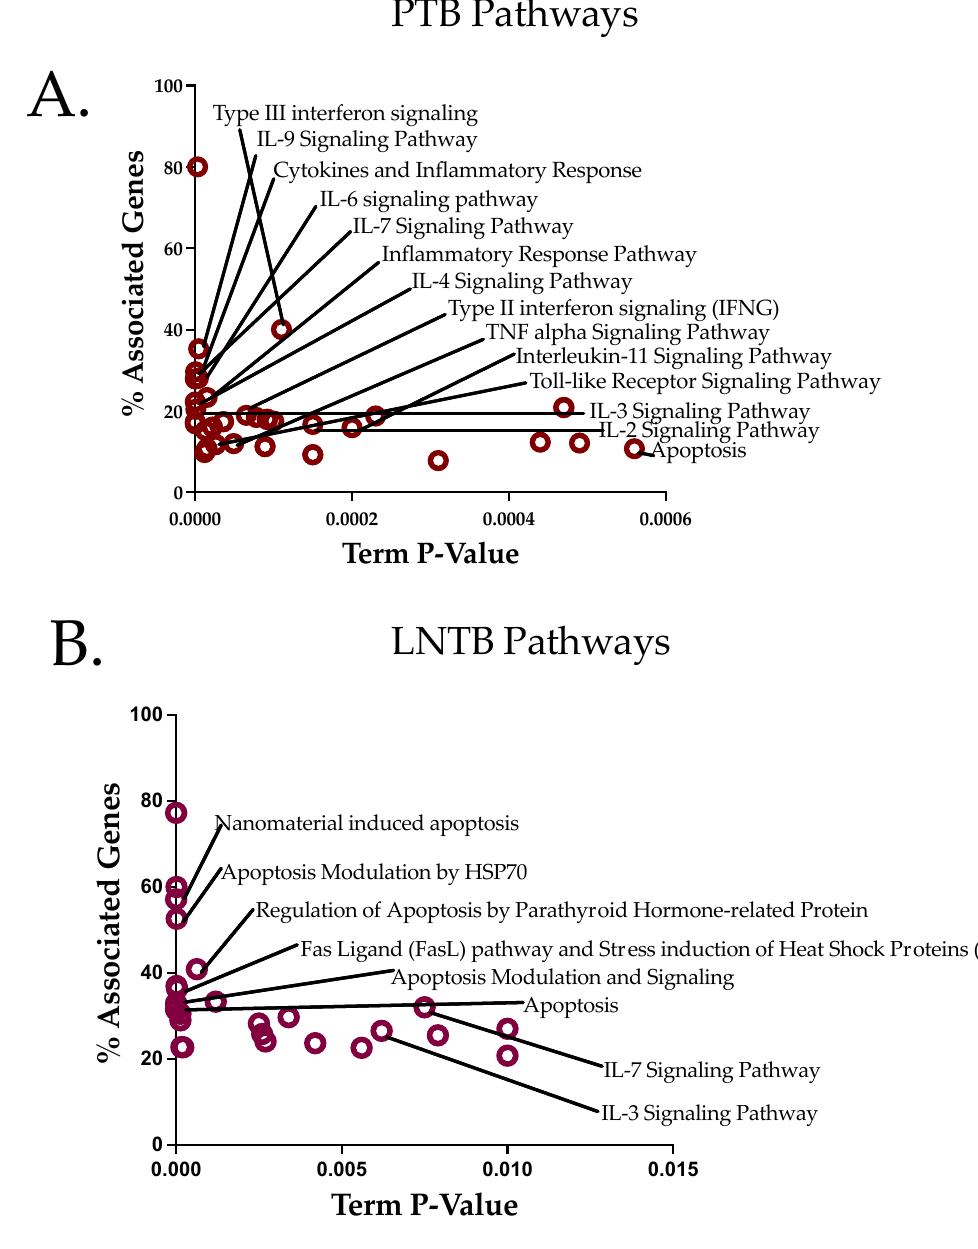
Figure 3. PTB and LNTB risk associated SNP related genes enrich in different pathways. Pathways enriched in PTB ( A ) and LNTB ( B ) through a pathway analysis based on the SNPs with significant p -values. The modules obtained from JActivemodules were used for enrichment in ClueGO App in Cytoscape. Two metrics, %Associated genes (proportion of genes in the pathway from the network of all genes) and Term p -value (enrichment p -value) is plotted here to show the abundance of the pathway with all the input genes and the p -value for the GO term obtained from WikiPathways.